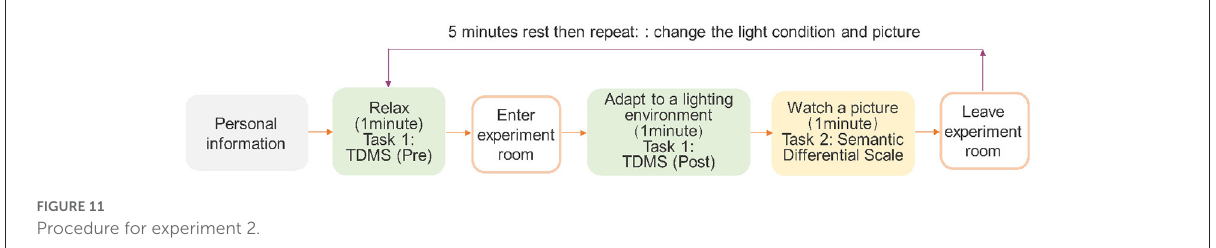
FIGURE11 Procedure for experiment